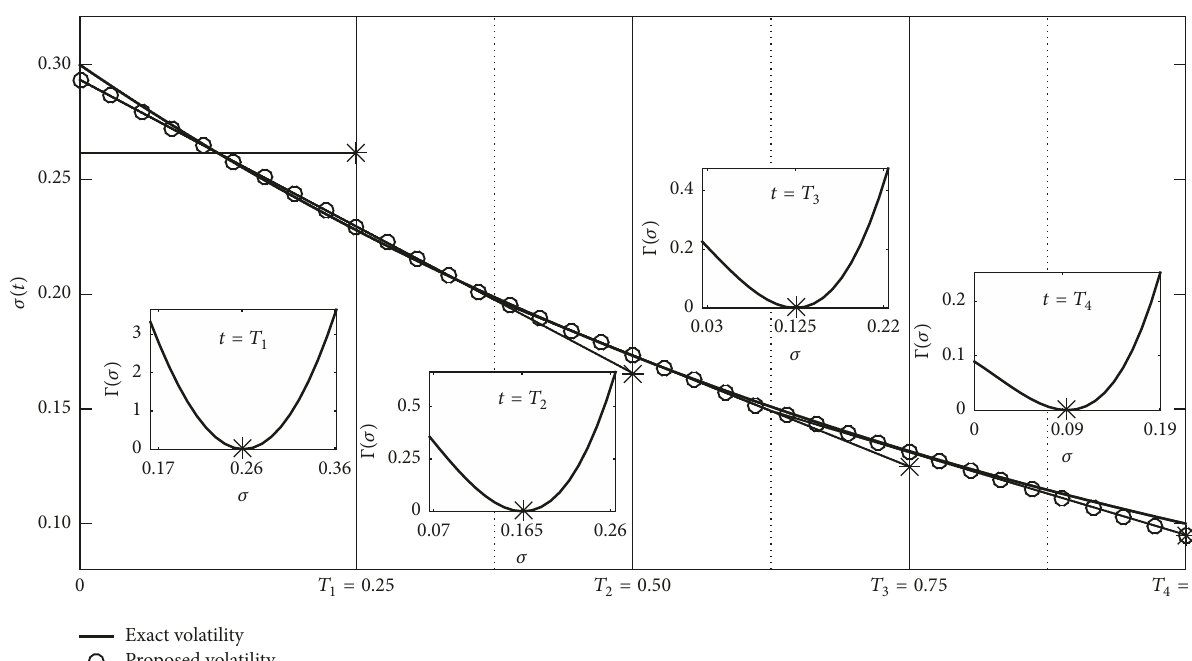
Figure 5: Estimated time-dependent volatility by our algorithm and the exact volatility function (16). Here, each small figure shows the cost function Γ(𝜎) as a function of 𝜎 and highlights the optimal value that minimizes Γ(𝜎) at time level 𝑡 = 𝑇 𝛼 for 𝛼 = 1, 2,3, 4 .